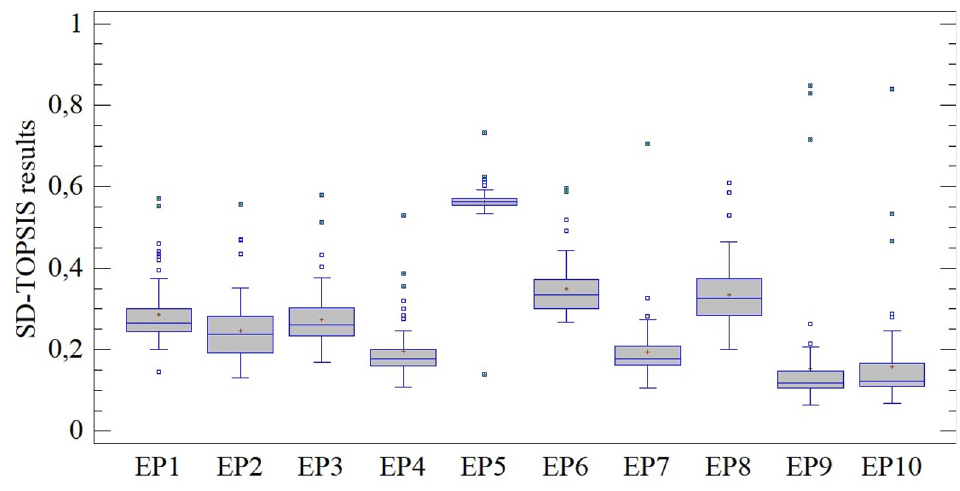
Fig 5. Results of assessment using the SD-TOPSIS